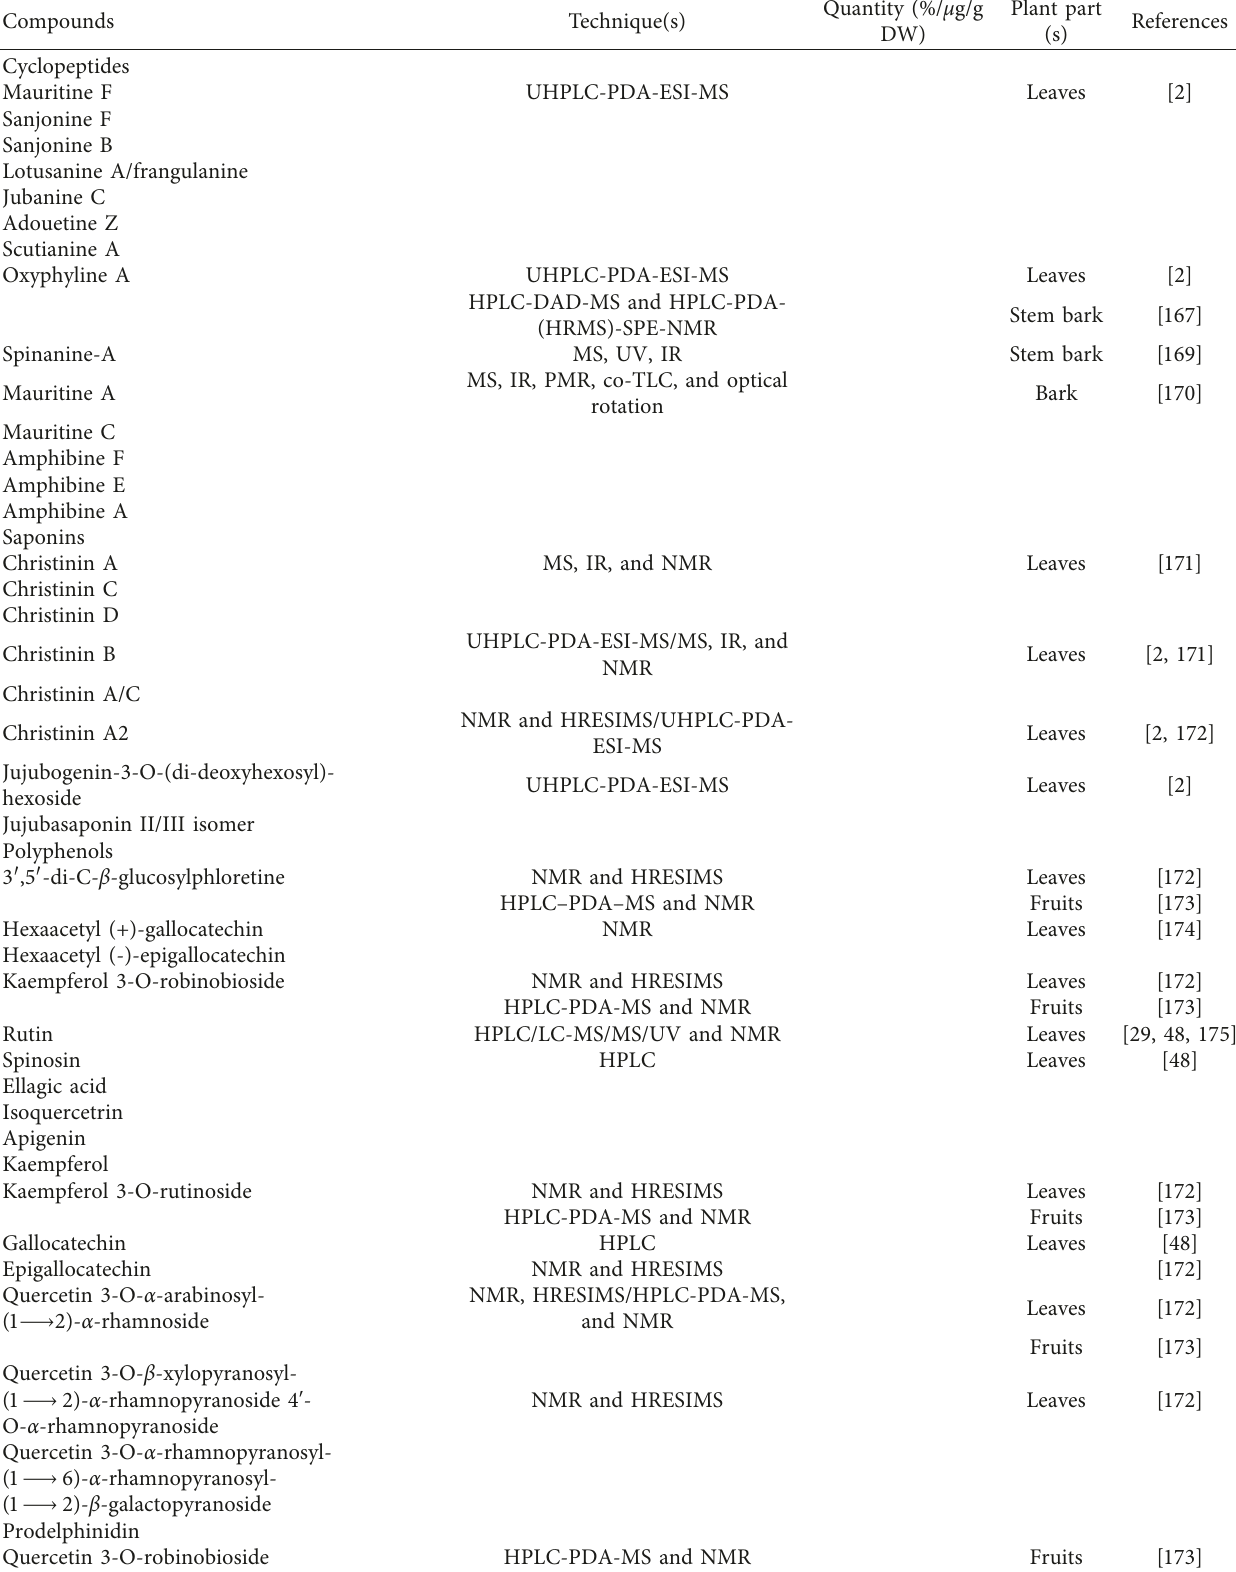
Table 2: Compounds reported from Z. spina